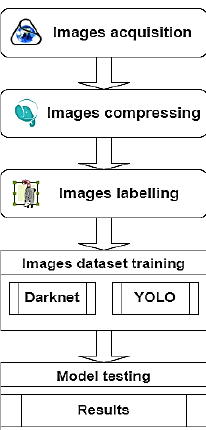
Figure 4. Workflow of geomembrane basins based on high resolution satellite images using deep learning algorithms